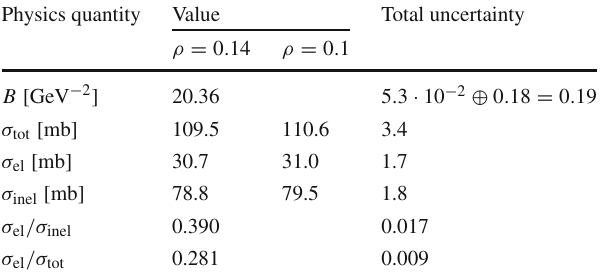
Table5 Thenuclearslope B ,thecrosssectionsandtheirsystematicand statistical uncertainty. The physics quantities are the weighted average of the DS1 and DS2 measurements